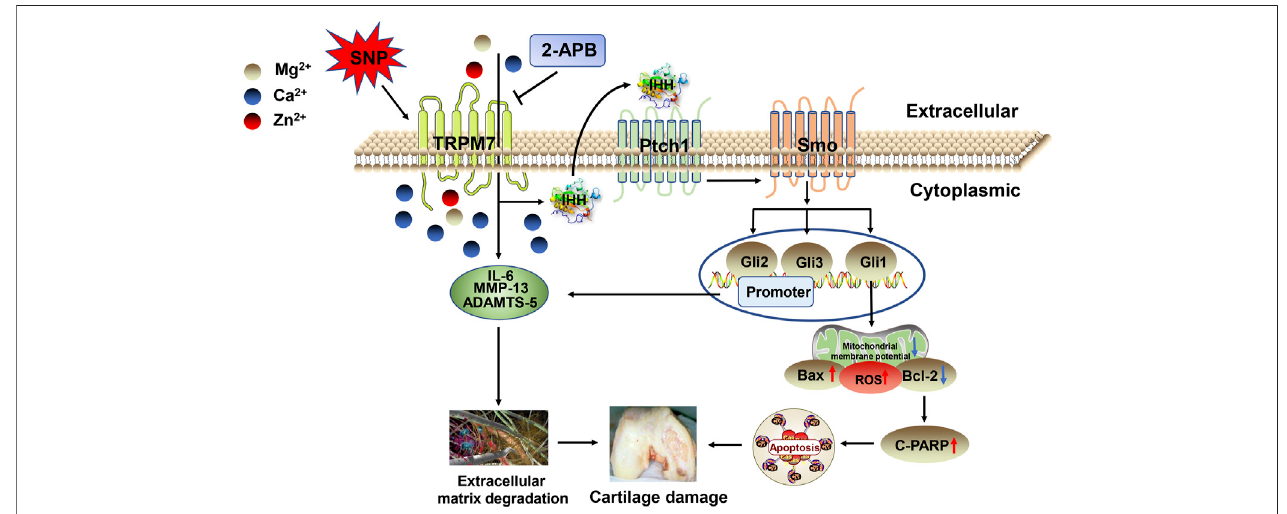
FIGURE 8 | Schematic depicting the roles of TRPM7 and IHH in articular chondrocyte apoptosis. SNP triggers an increase in TRPM7 and IHH and promotes the expression of apoptotic proteins, leading to chondrocyte apoptosis. Activation of TRPM7 and IHH also enhances expression of IL-6, MMP-13, and ADAMTS-5, which promotes cartilage damage and aggravates the process of